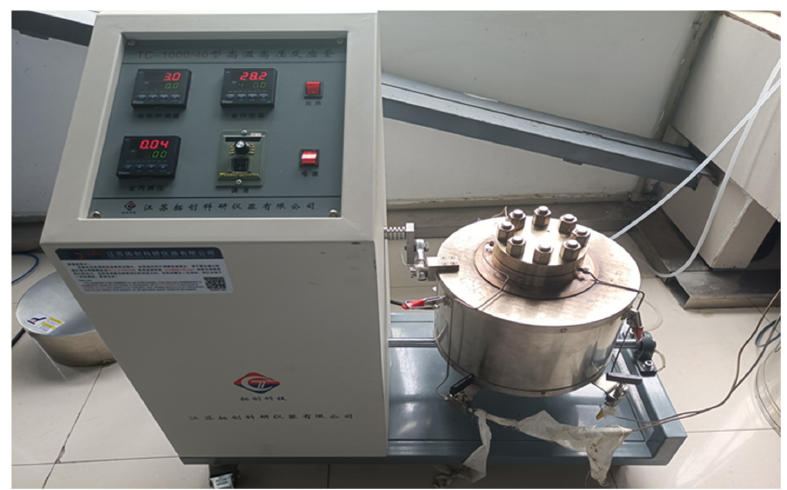
Figure A3. High temperature and high pressure reactor for the generation experiments.